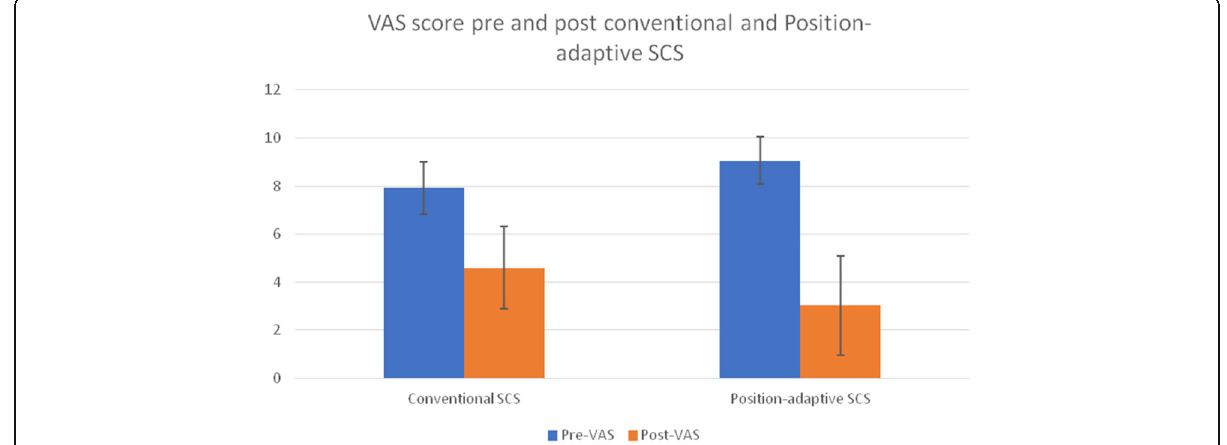
Fig. 1 Comparison between the two treatment groups regarding the change in VAS scores. VAS, visual analog scale. SCS, spinal cord